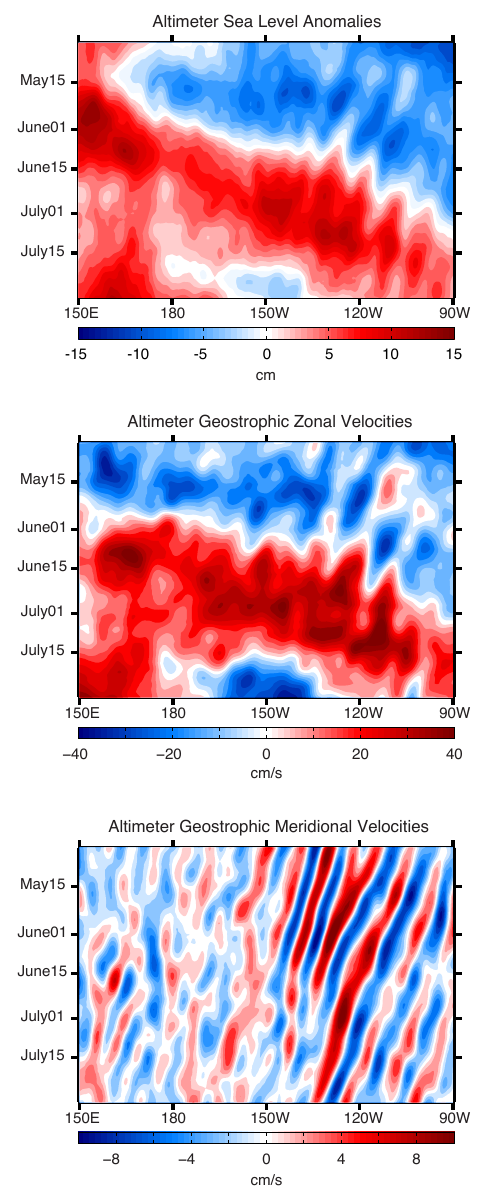
Fig. 4. Longitude-time plots of anomalous daily (A) sea-level height, (B) geostrophic zonal velocity (eastward positive), and (C) geostrophic meridional velocity (northward positive), derived from the SSALTO/DUACS multi-satellite altimetry data product. Sea-level height and geostrophic zonal velocity anomalies are aver- aged between − 2 and +2 ◦ N, and geostrophic meridional velocity anomalies are averaged between − 5 and +5 ◦ N. All quantities are spatially filtered using a 2-D 1.65 ◦ mean filter.